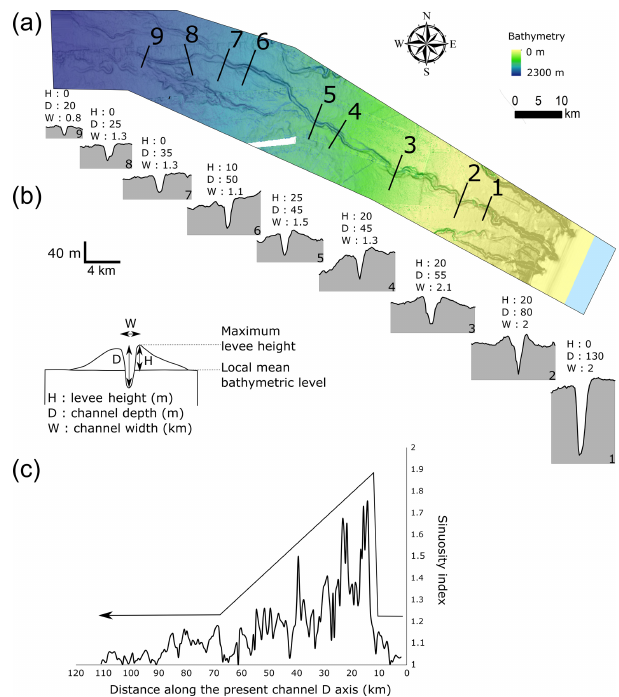
Figure 7. (a) Detailed bathymetric map of channel D (location in Fig. 2), (b) serial bathymetric profiles showing the evolution of the channel–levees along the slope and (c) sinuosity down the channel D measured along 2km channel segments.